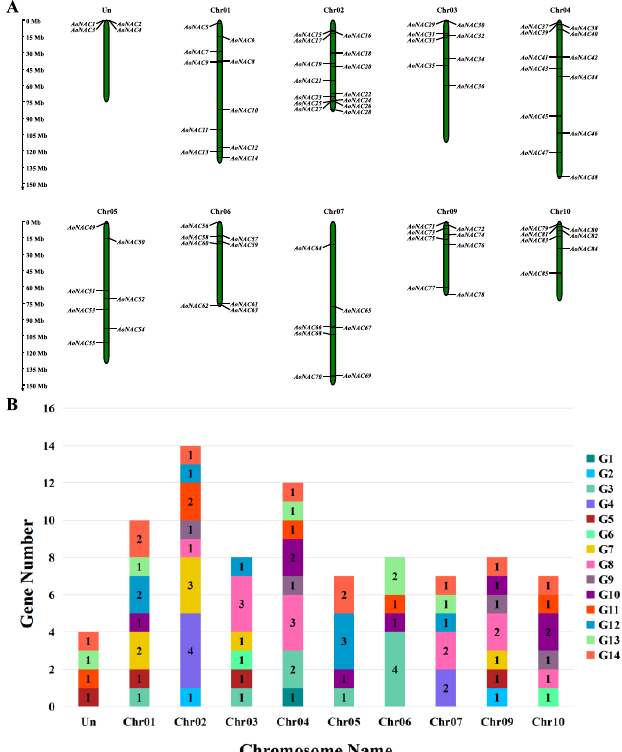
Figure 3. ( A ) Physical distribution of AoNAC genes on 9 chromosomes (Chr01–Chr09) and an undefined chromosome (Un). Vertical bars represent the chromosome of A. officinalis . The scale is in 15 Mb. ( B ) Number of AoNAC subgroups on each chromosome.